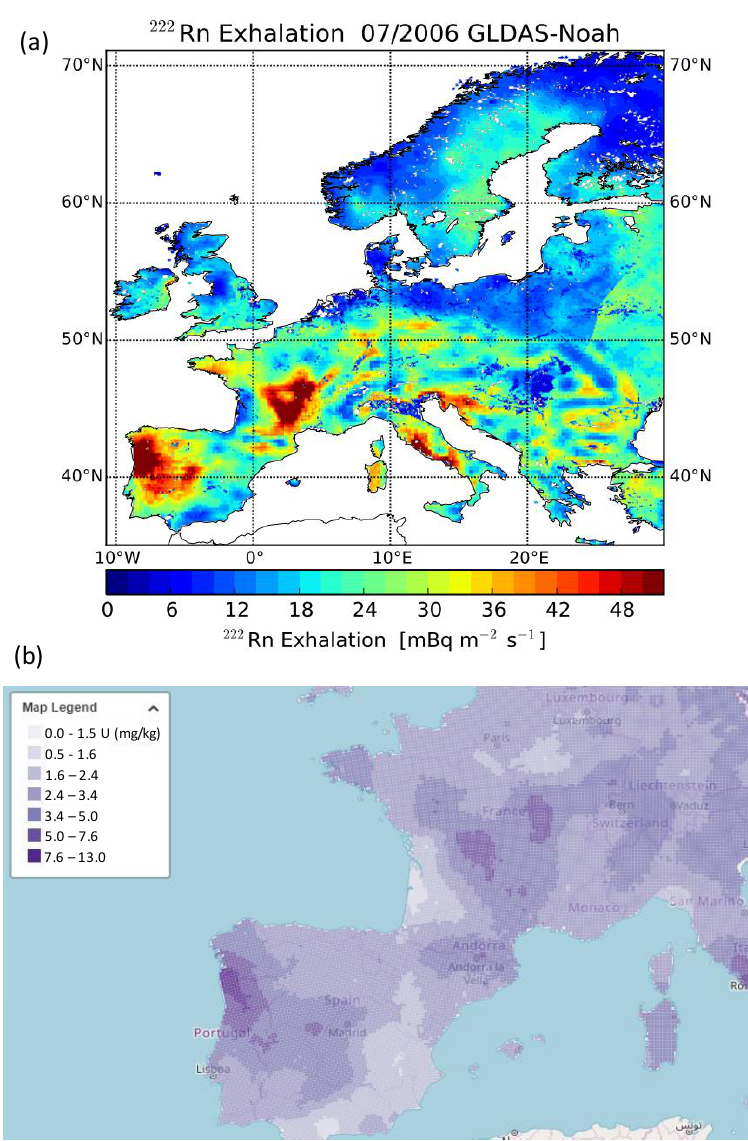
Figure 10. ( a ) 222 Rn exhalation rate map of European soils, for July 2006 calculated with the monthly mean soil moisture estimates from the GLDAS Noah LSM for July 2006, from [20] ; ( b ) Screenshot of the European Map of Uranium in soil available on REMONwebportal (https://remon.jrc.ec.europa.eu/About/Atlas-of-Natural-Radiation/Digital-Atlas/Uranium-in-soil/U ranium-concentration-in-soil-, accessed on 10 October 2022).